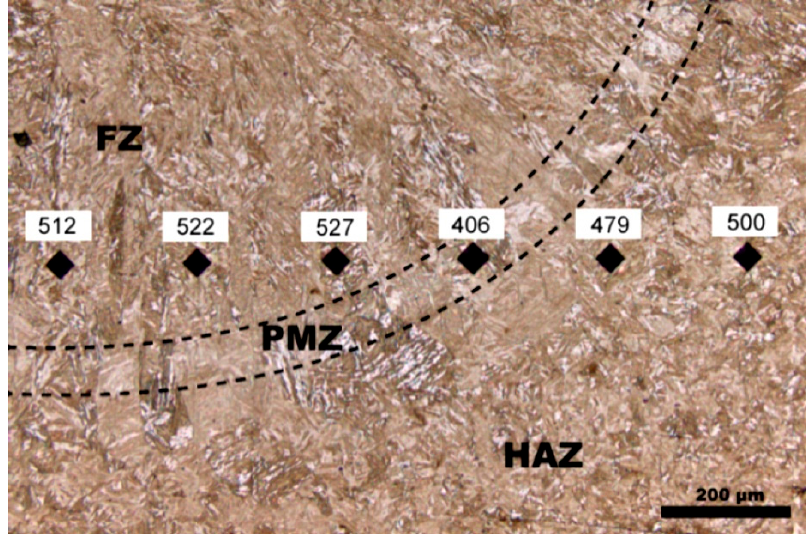
Figure 8. Hardness distribution in nearby partially melted zone (PMZ) at 6.0 kA in the two-step RSW.